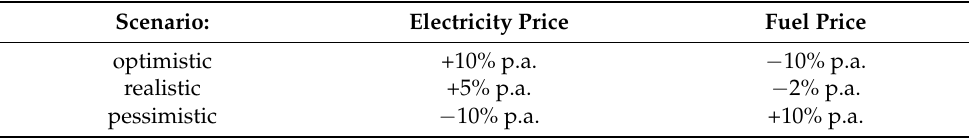
Table 4. Electricity and fuel prices in optimistic, realistic and pessimistic scenarios.